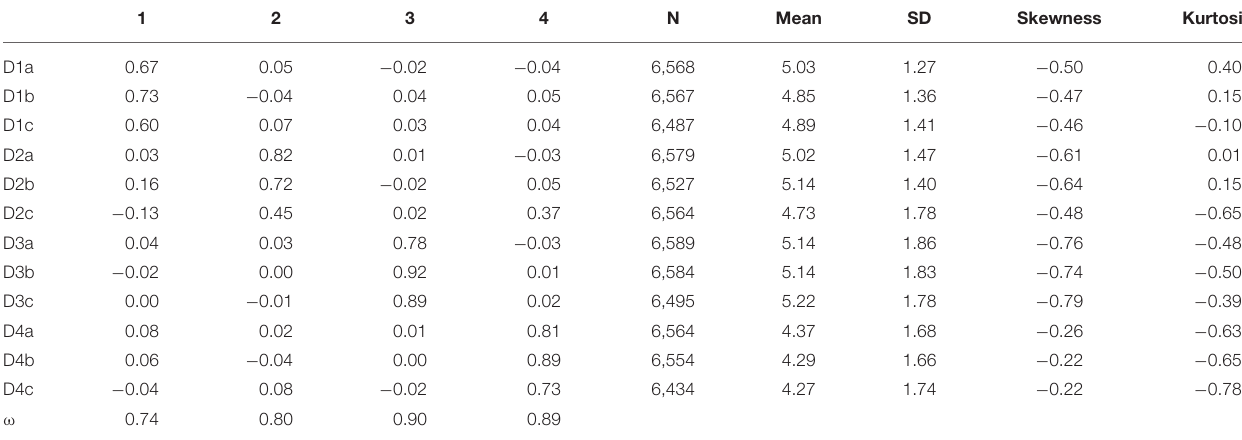
TABLE 2 | Results of exploratory structural equation modeling, omega and descriptive statistics.